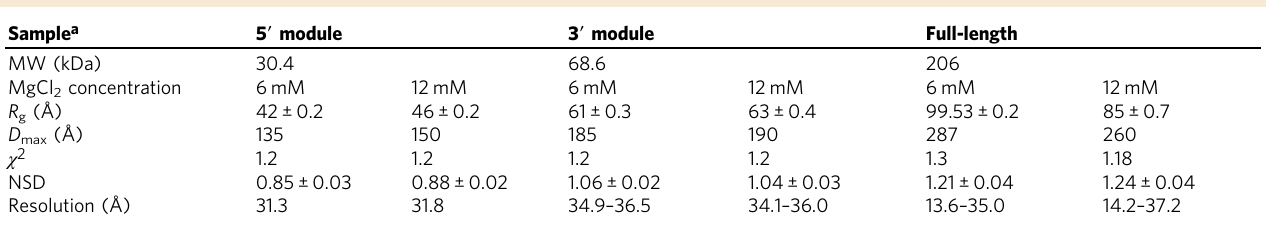
Table 2 Structural characteristics of independent Bvht modules.